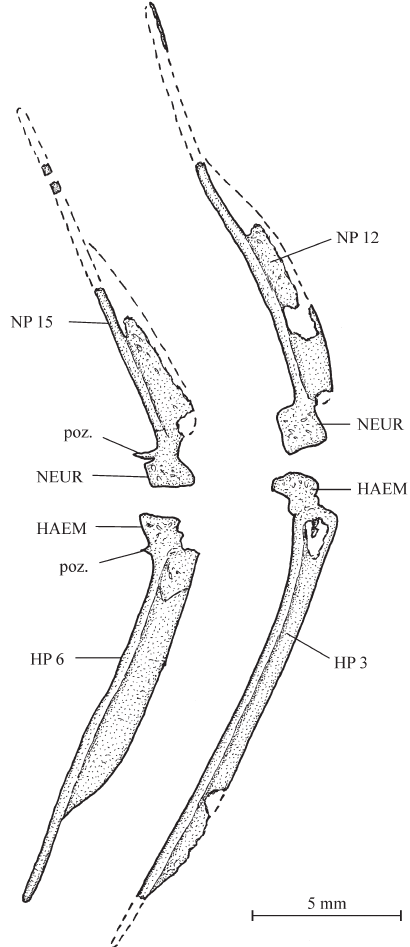
Fig. 12. Acrorhinichthys poyatoi gen. et sp. nov. Holotype CLC S-630b. Two vertebral segments, at the level of the twelfth and the fifteenth neural